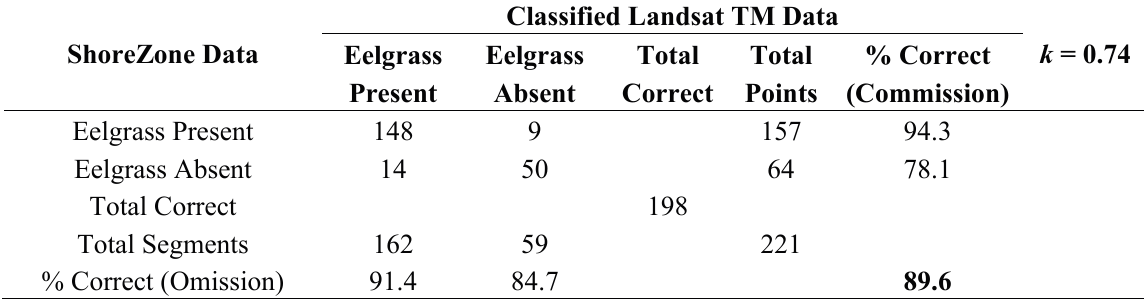
Table B1. Accuracy assessment of ShoreZone eelgrass detection in Izembek